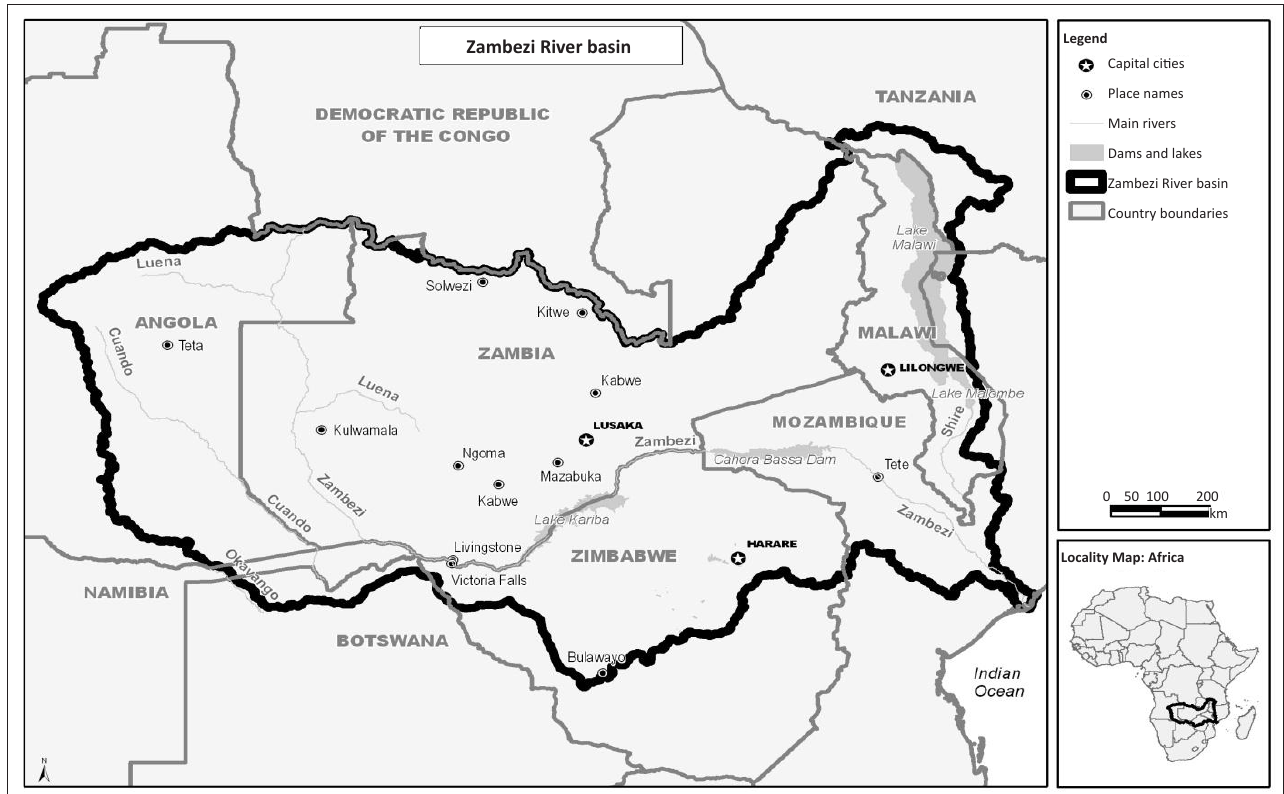
FIGURE 1: Zambezi River